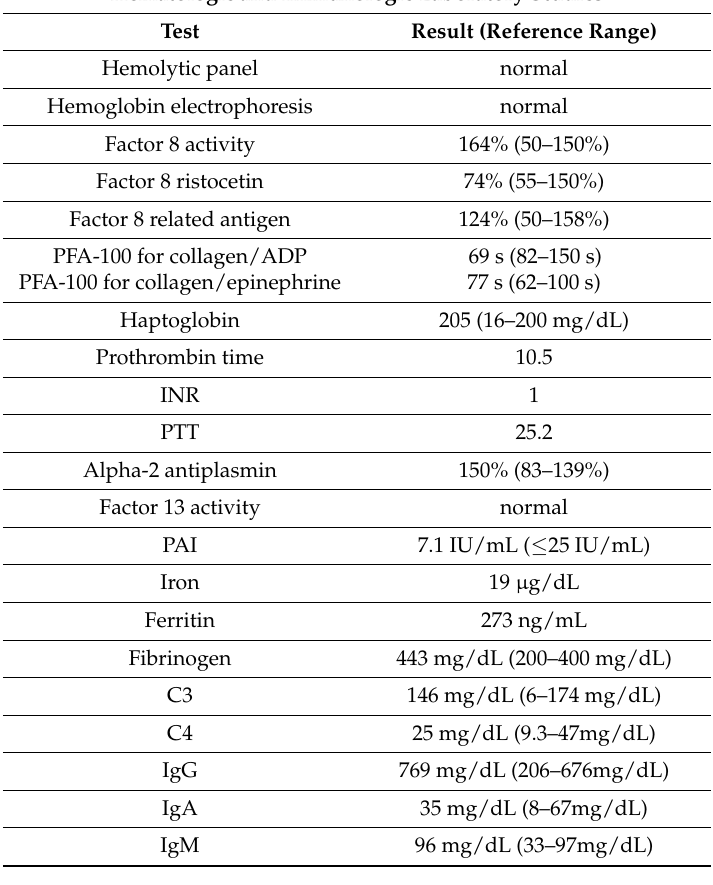
Table 1. Hematologic and rheumatologic diagnostic tests, patient results, and reference ranges (dL, deciliter; INR, international normalized ratio; IU, international unit; μ g/, microgram; mg, milligram;